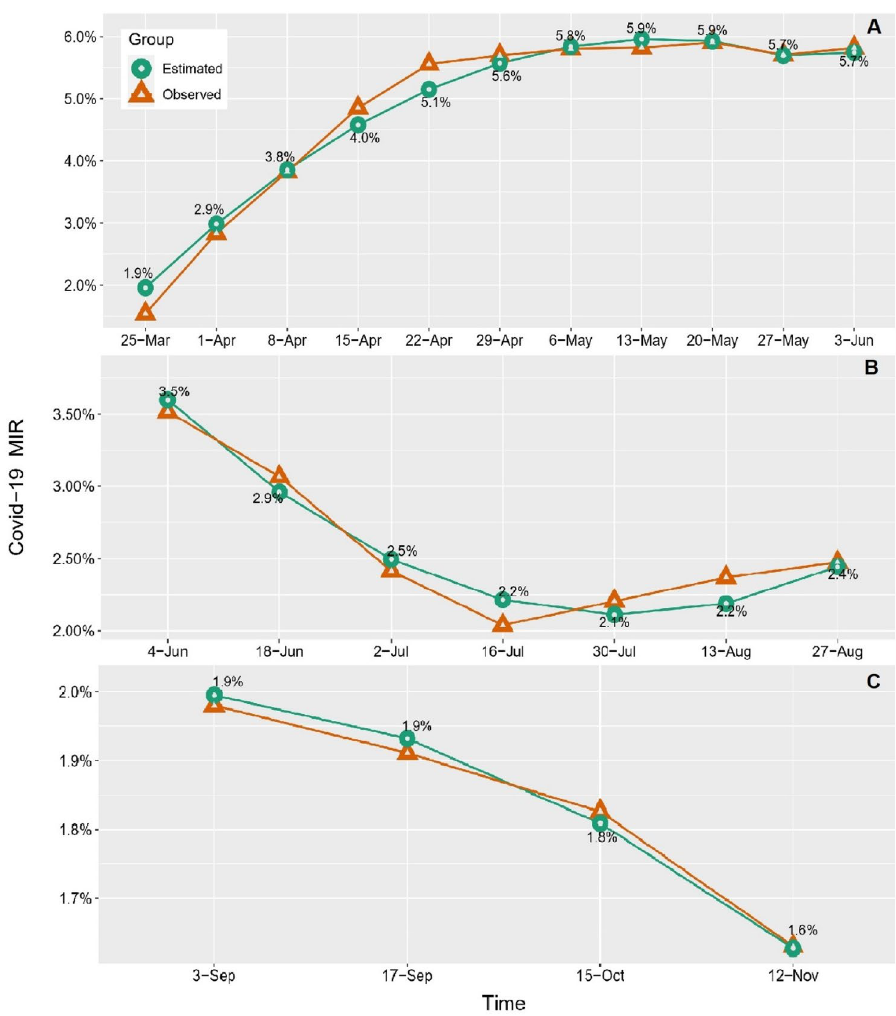
Figure 1. Overall growth trajectories of observed and estimated COVID-19 MIR for the ( A) . 1st wave, ( B) 2nd wave, and ( C) 3rd wave. Green lines indicate the estimated MIR trajectories using an LGM model (linear and non-linear). Orange lines indicate the observed mean